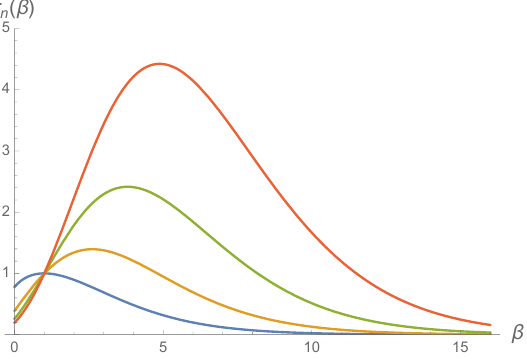
Figure 1. The function r n ( β ) of the Weibull distribution for n = 1,2,3,4 from bottom to top near β =